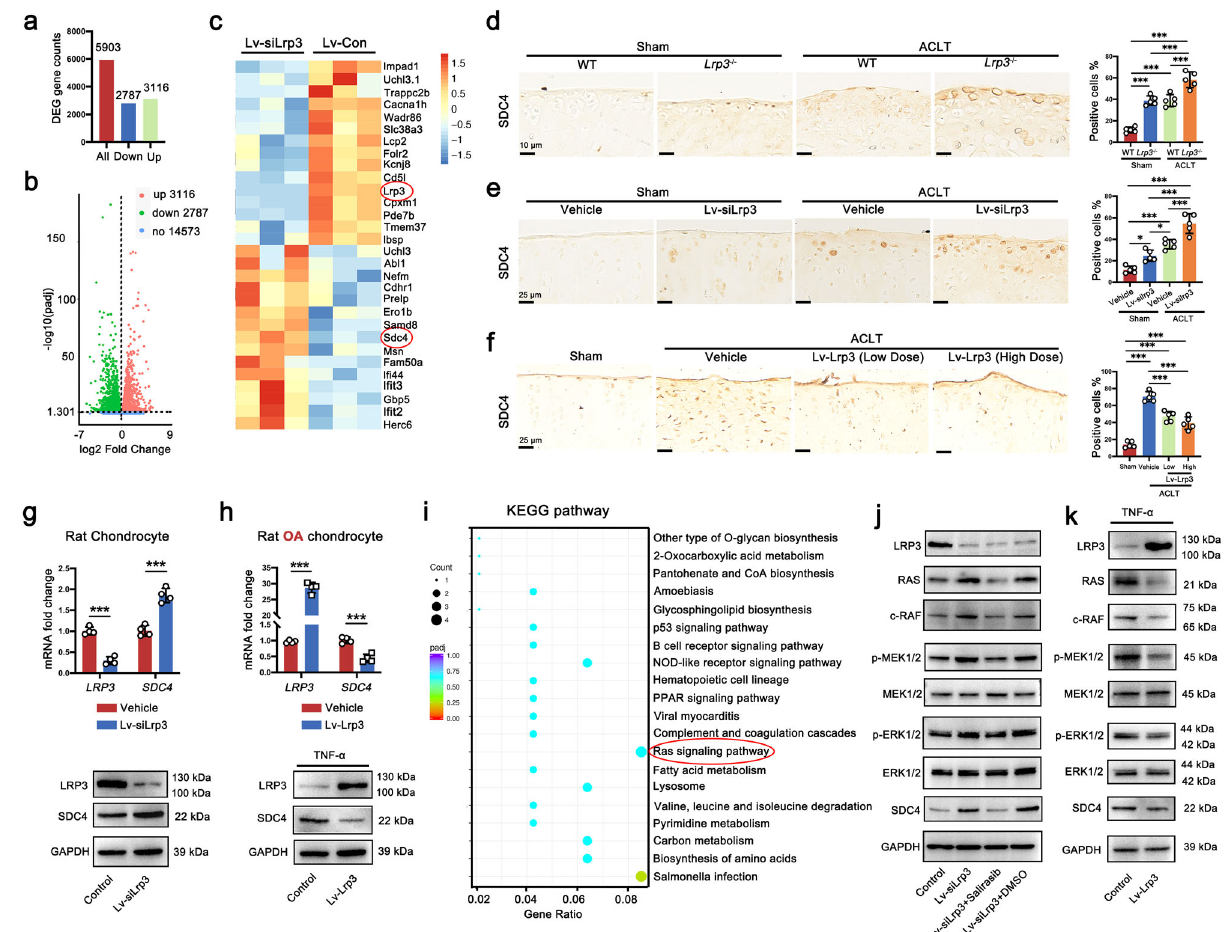
Fig. 6 | Knockdown of LRP3 upregulates the expression of SDC4 by activating the Ras/Raf/MEK/ERK signaling pathway in chondrocytes. a RNA-seq compar- ison revealed a total of 5930 genes expressed, of which 3116 genes were upregu- lated and 2787 genes were downregulated. b The volcano plot illustrating differential genes from RNA-seq analysis. c Heatmap of mRNA-seq analysis in rat chondrocytestreatedwithLv-con313orLv-siLrp3. d RepresentativeimagesofLRP3 IHC staining of knee joints from WT and LRP3 − / − mice subjected to Sham or ACLT operation( n =5,one-wayANOVA). e RepresentativeimagesofLRP3IHCstainingof knee joints from vehicle or Lv-siLrp3 injected rats subjected to Sham or ACLT operation( n =5,one-wayANOVA). f RepresentativeimagesofLRP3IHCstainingof kneejointsfromSham,Vehicle,andLv-Lrp3treatmentrats( n =5,one-wayANOVA). g Quanti fi cation of LRP3 and SDC4 mRNA ( n =4, two-tailed Student ’ s t -test) and